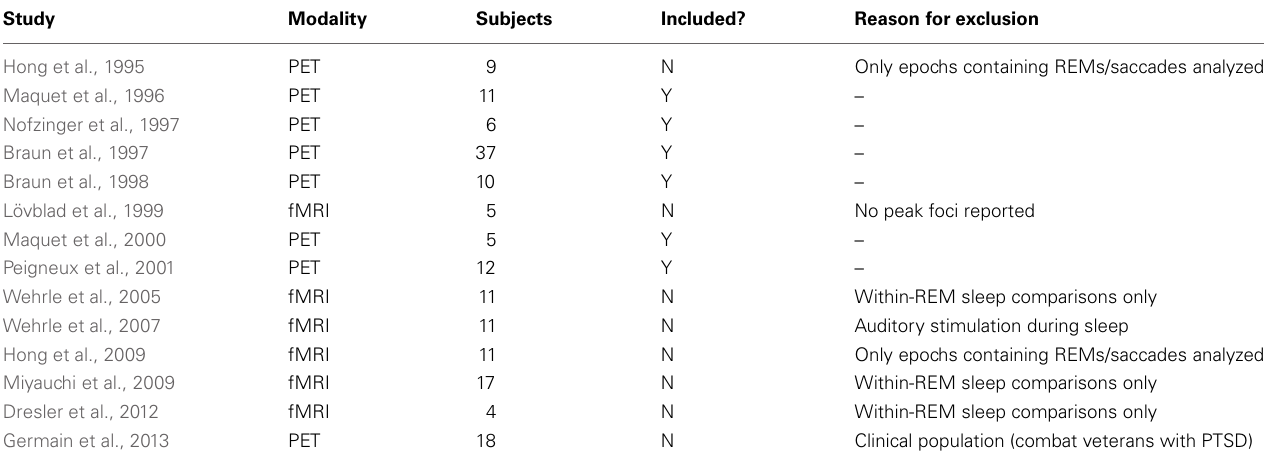
Table A1 | Summary of included and excluded neuroimaging studies of REM